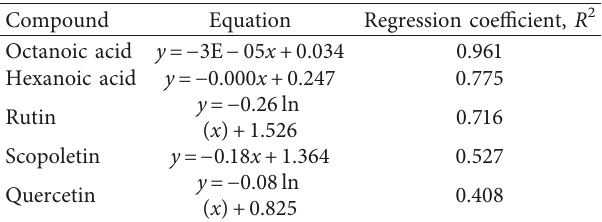
Table 7: Equation and regression coefficient of Peleg’s capacity constant for organic acids (octanoic acid and hexanoic acid)